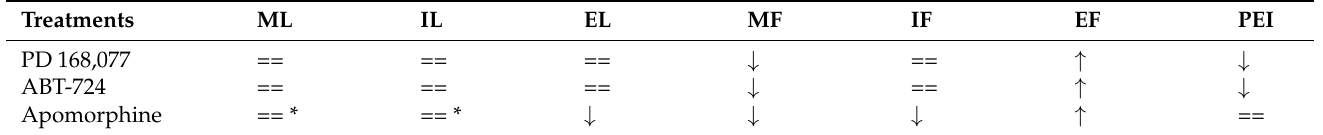
Table 8. Changes in copulatory behavior of sexually potent male rats induced by the D 4 receptor agonists PD 168,077 and ABT-724: comparison with